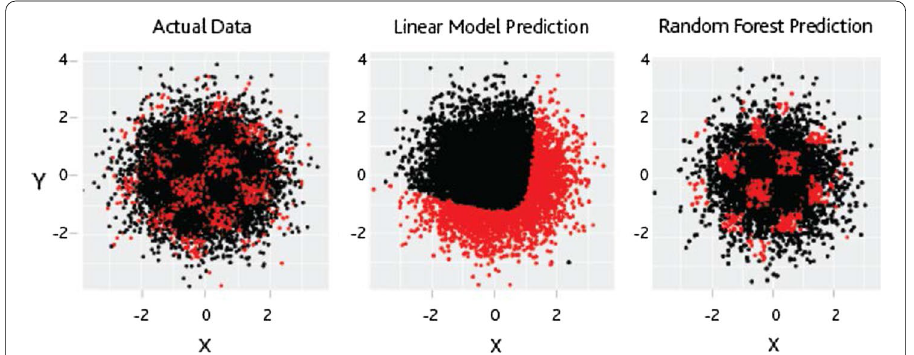
Fig. 2 Statistical model machine learning. Source: Bacham and Zhao ×